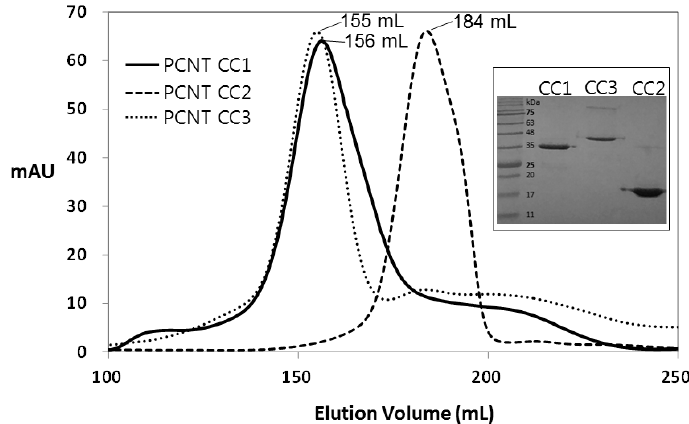
Figure 2. Size-exclusion chromatograms of three PCNT coiled-coil proteins (CC1, CC2, and CC3) and SDS-PAGE analysis of the concentrated fractions under the elution peaks (inset).